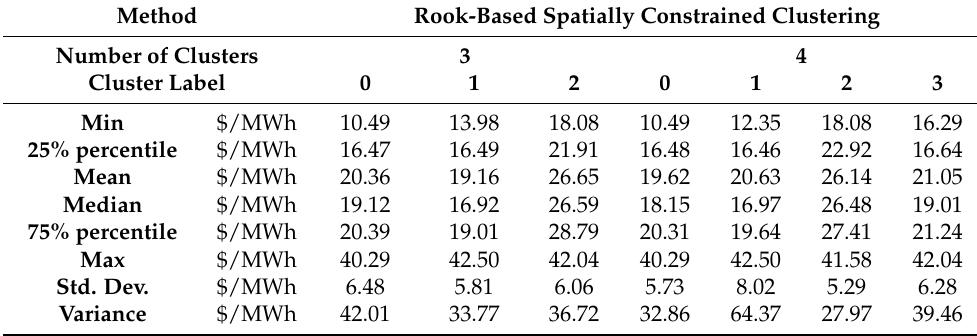
Table 3. Statistical measures of rook-based spatially constrained clustering.